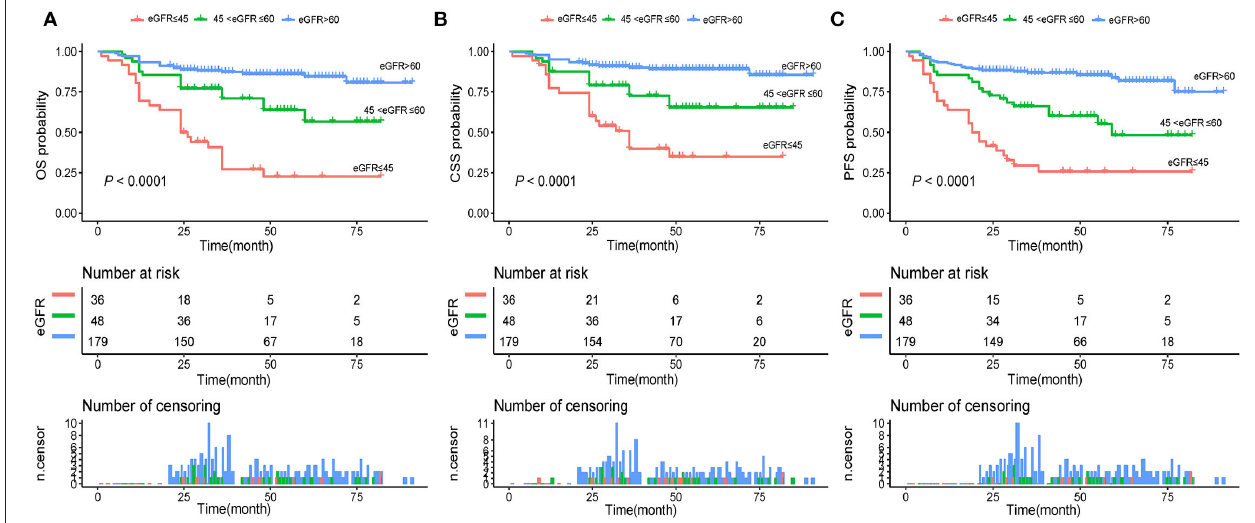
FIGURE 2 | (A) Kaplan–Meier curves for OS of patients with UTUC stratified by postoperative eGFR groups; (B) Kaplan–Meier curves for CSS of patients with UTUC stratified by postoperative eGFR groups; (C) Kaplan–Meier curves for PFS of patients with UTUC stratified by postoperative eGFR groups. UTUC, upper tract urothelial carcinoma; eGFR, estimated glomerular filtration rate; OS, overall survival; CSS, cancer-specific survival; PFS, progression free survival.